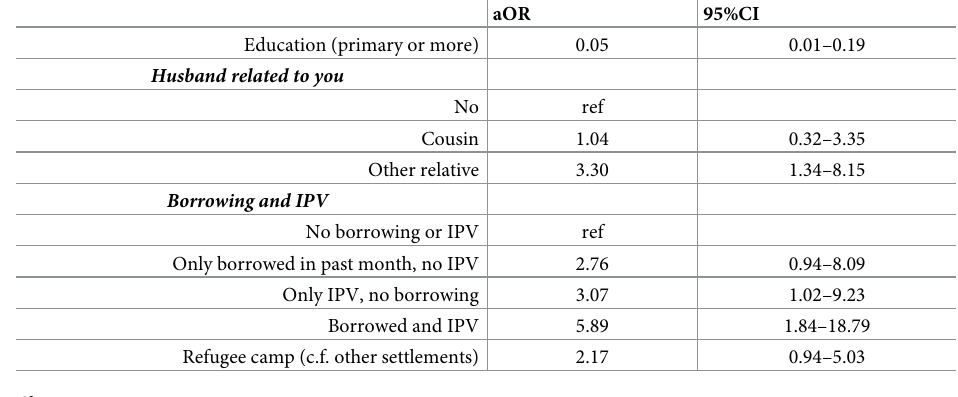
Table 5. Factors associated with ‘honour killing’ amongst married women in the occupied Palestinian Territories (n = 412).